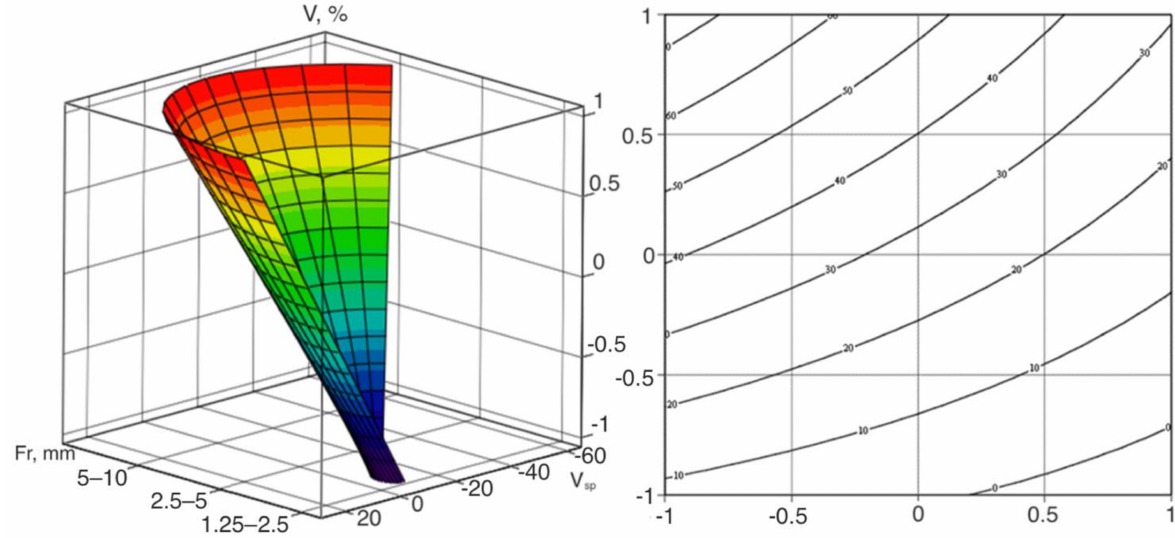
Figure 6. Dependence of the voidness of a slag pumice mixture on the volumetric content of various types of fractions.